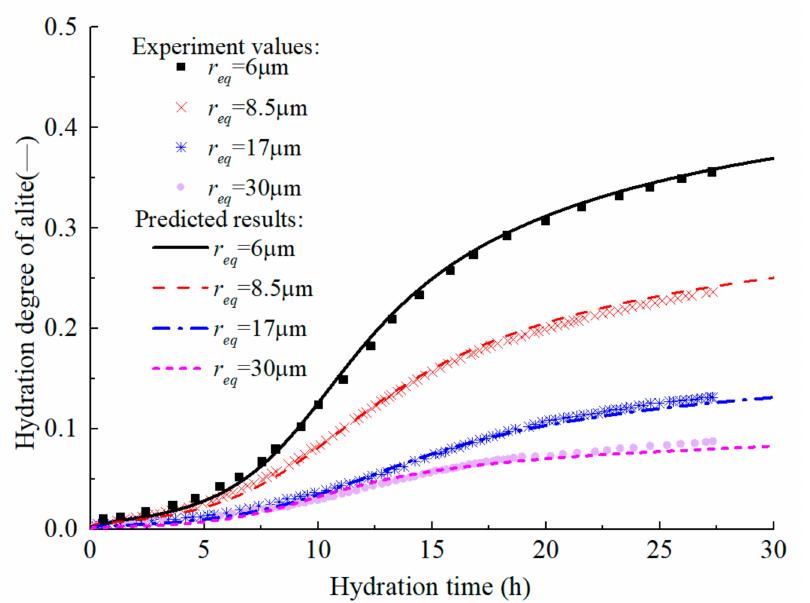
Figure 5. Experimental values and prediction curves of hydration degree of alite in early